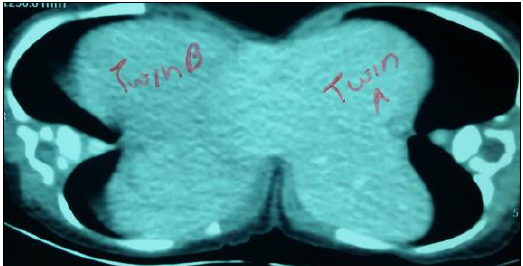
Figure 2: Contrast CT-scan showing differential enhancement of livers of both